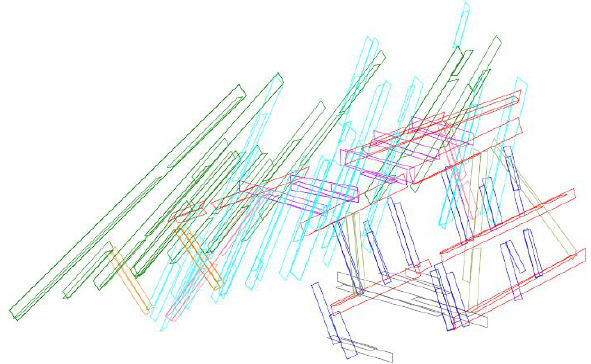
Figure 9: Adjacent beam segments are associated to describe a beam; Different colors represent different roles in the structural